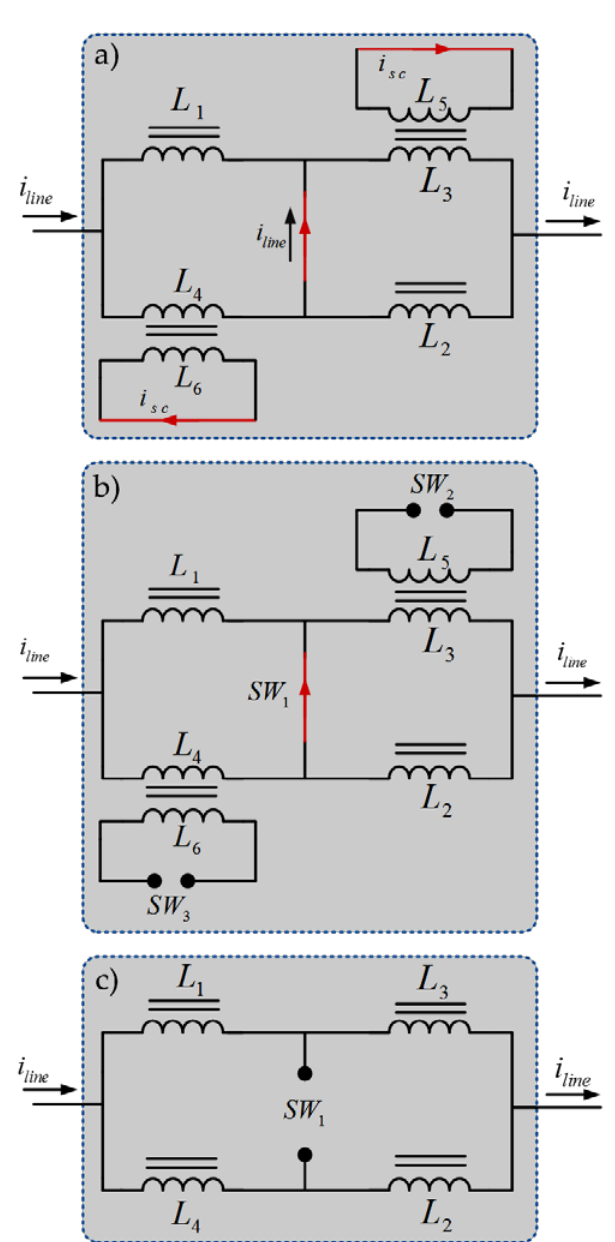
Figure 2. HBFCL equivalent circuit. ( a ) Normal operation mode, ( b ) fault operation mode in first state, and ( c ) fault operation mode in second state.